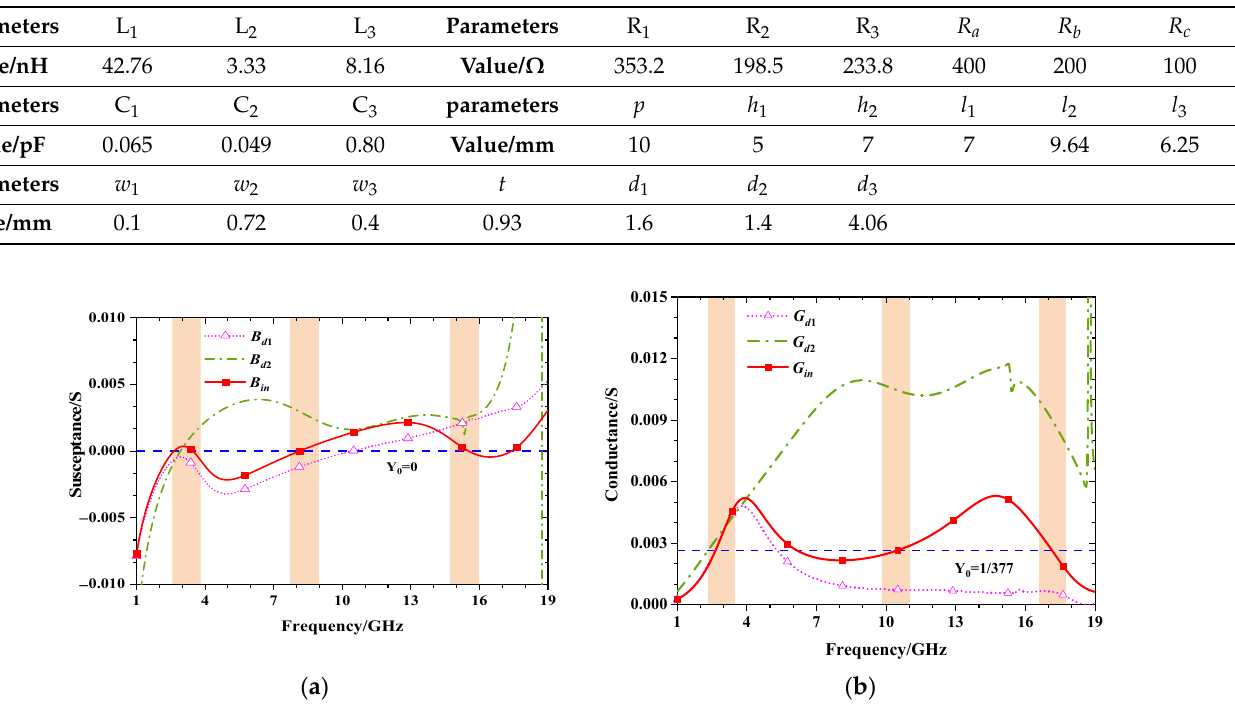
Figure 4. Extract imaginary ( a ) and real ( b ) parts of Y d1 , Y d2 , and Y in . The pink part represents the frequency band that meets the resonance requirements.